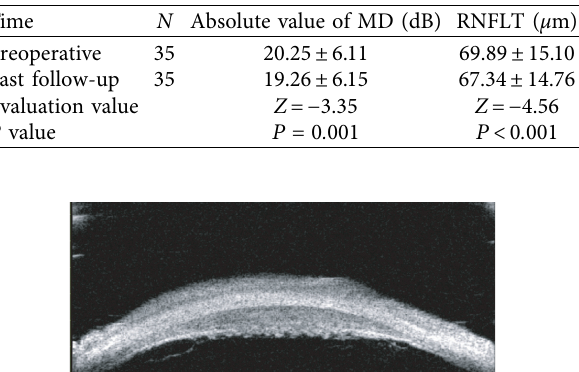
Table 1: Absolute value of the MD and RNFLT before and after the operation.